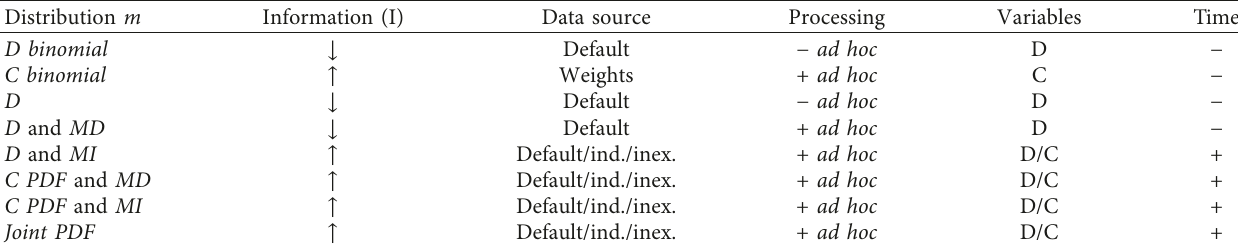
Table 1: Probabilistic distributions of information in workflows.